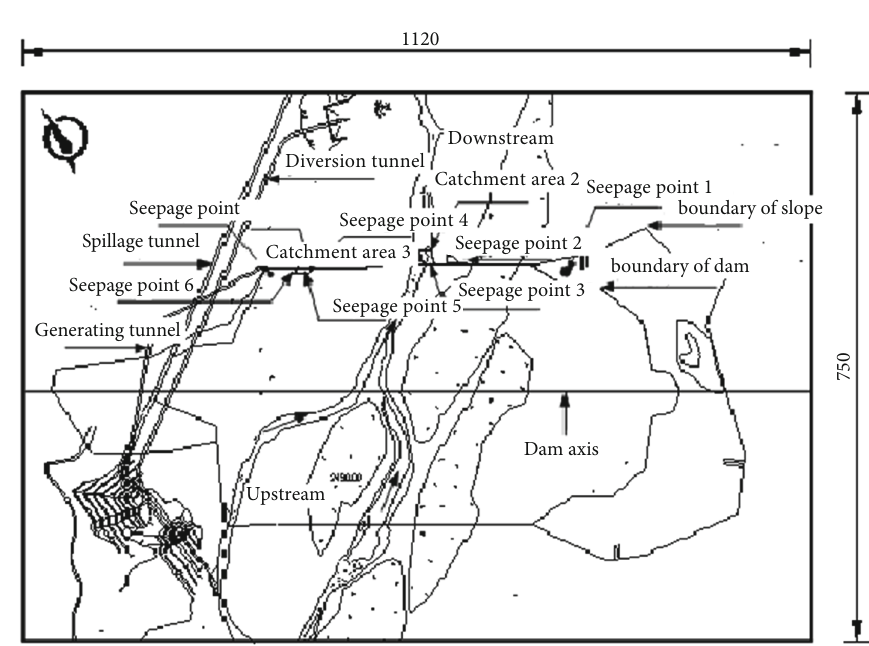
Figure 2: The range of calculative domain.